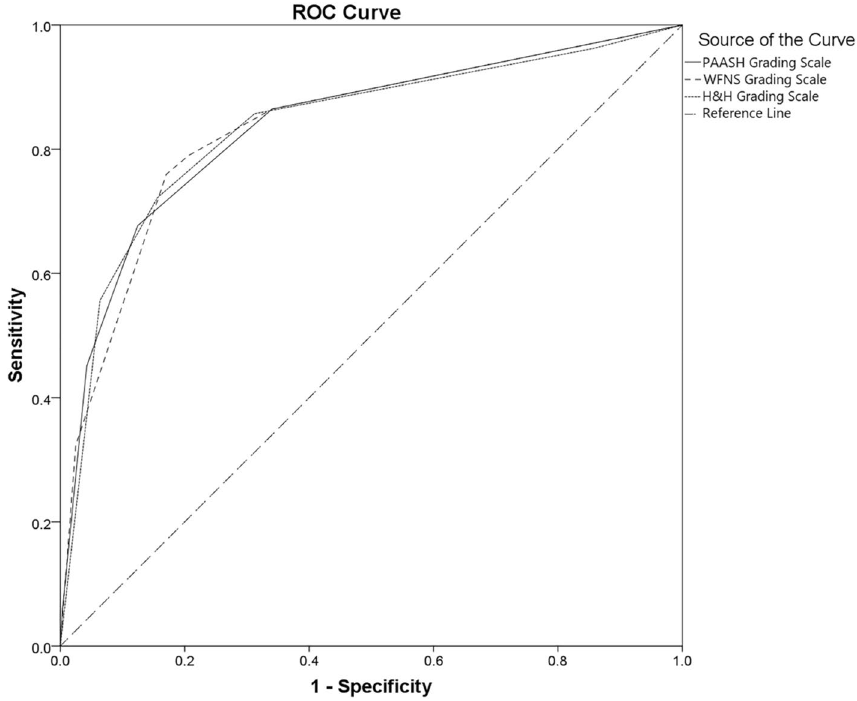
Figure 3. The overall prognostic performance of the SAH grading scales for the poor outcomes on day 90th after ictus: The area under the ROC curves of the PAASH (AUROC: 0.838 [95% CI 0.794–0.882]; cut-off value: ≥ 2.5; sensitivity: 67.7%; specificity: 87.6%; P AUROC < 0.001), the WFNS (AUROC: 0.837 [95% CI 0.793–0.881]; cut-off value: ≥ 3.5; sensitivity: 75.9%; specificity: 83.0%; P AUROC < 0.001), and the H&H scales (AUROC: 0.836 [95% CI 0.791–0.881]; cut-off value: ≥ 3.5; sensitivity: 72.2%; specificity: 84.4%; P AUROC < 0.001) for predicting the poor outcomes on day 90th after ictus in patients with aneurysmal SAH ( AUROC areas under the